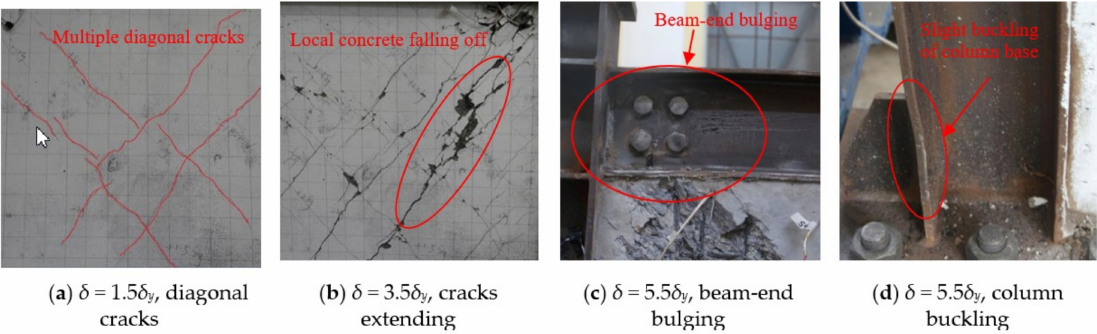
Figure 5. Local failure of SPE2.